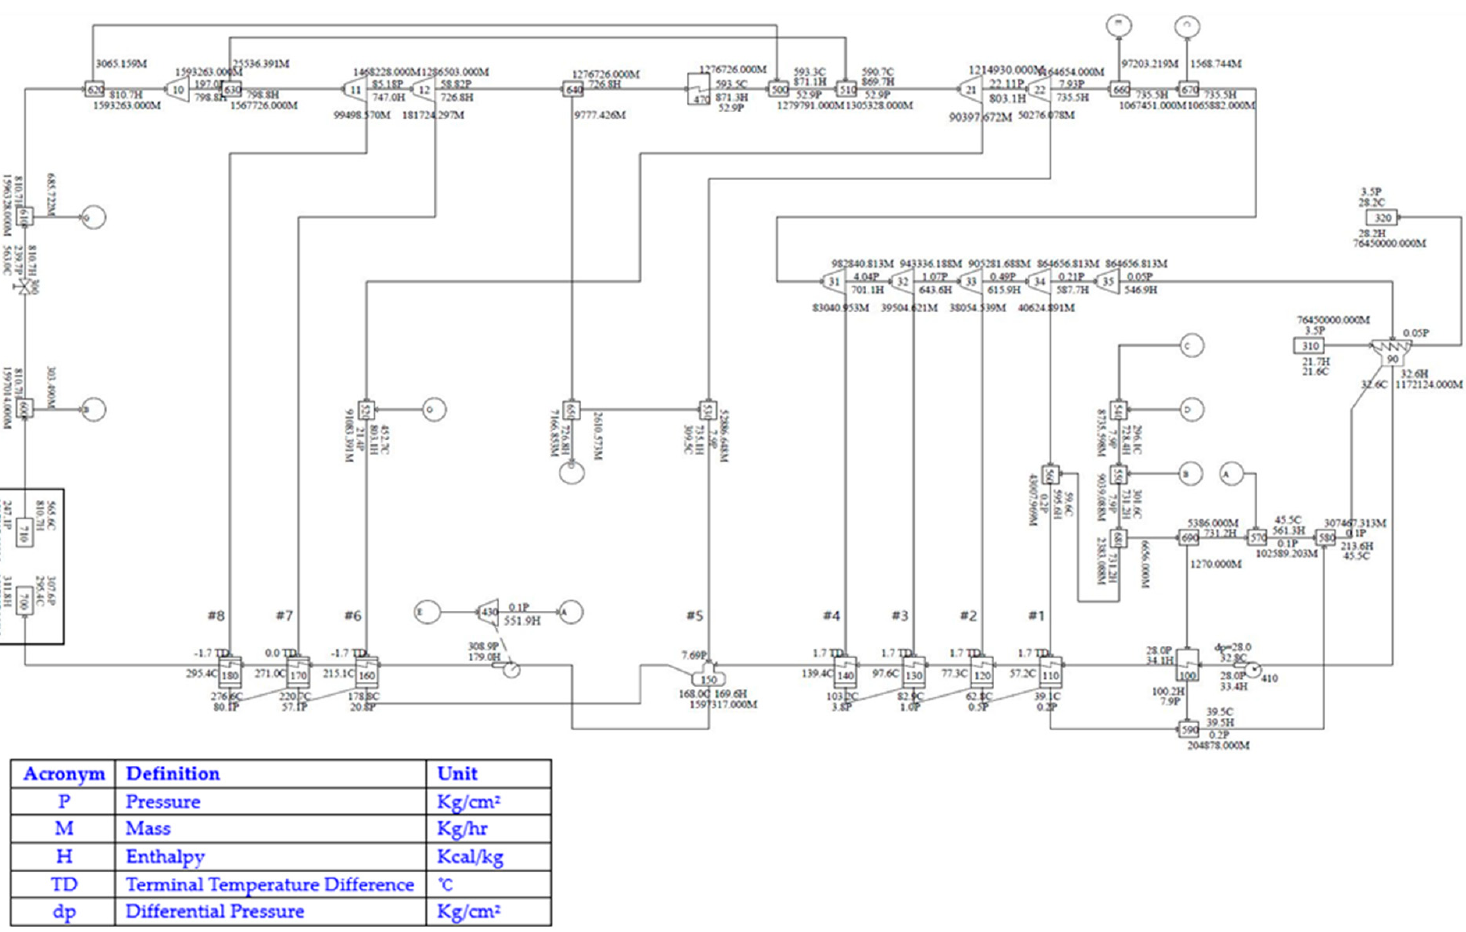
Figure 5. Simulation USC model (SR+8FWH) .